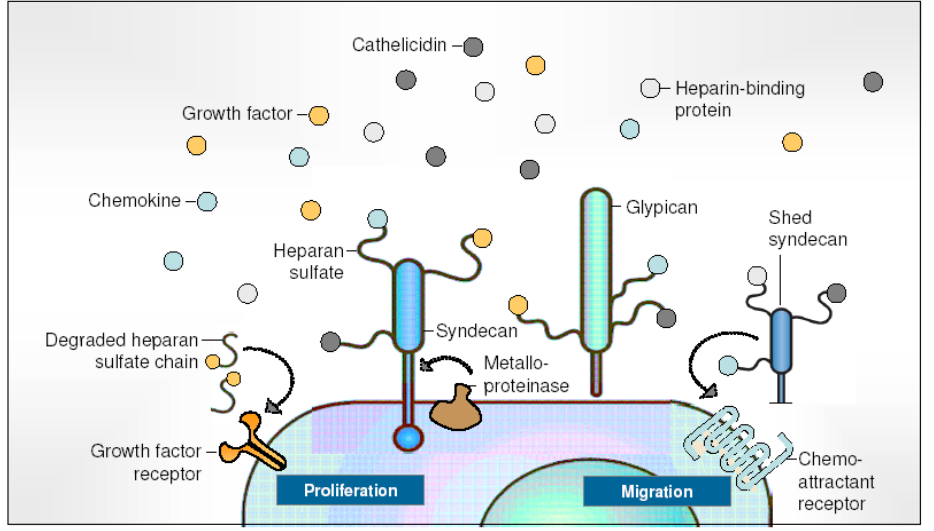
FIGURE 1. The role of HSPGs in mediating immunomodulatory effects of cathelicidins. Following an infectious stimulus, leukocytes and various types of tissue cells produce and release heparin-binding molecules, such as chemokines, growth factors, heparin-binding proteins, and antimicrobial peptides, such as cathelicidins, that bind with high affinity to host and bacterial binding sites, and associate with their diverse heparan sulfate–binding domains on matrix and cell surface proteoglycans. Ligand affinity and concentration determine competitive displacement of heparan sulfate–bound mediators. Activation or inhibition of proteases and heparanases alter constitutive shedding of HSPGs. Binding of cathelicidins to HSPG may alter focal adhesion kinase signaling of syndecan-4 directly; affect coreceptor function of syndecans and glypicans, e.g., by activation of metalloproteinase and syndecan ectodomain shedding or by modification of enzymatic degradation of heparan sulfates by heparanase; and transactivate surface receptors of inflammatory cells, including the formyl peptide receptor, formyl peptide receptor like-1, purinergic receptor, epidermal growth factor receptor, or chemokine receptors. Binding of cathelicidins to heparan sulfate and shedding of HSPGs from cell surfaces at the same time affects microbial virulence and antimicrobial effects of the